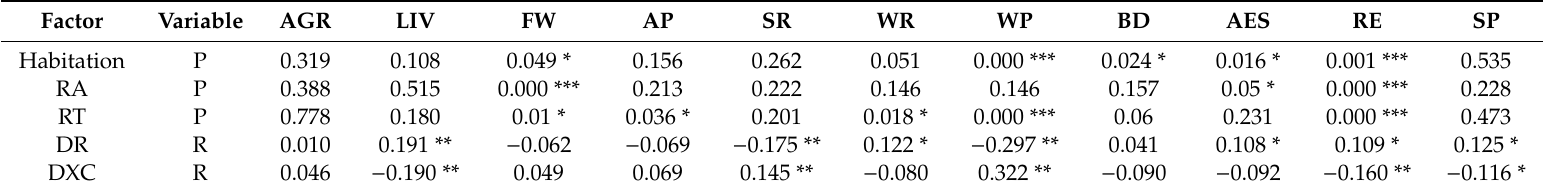
Table 2. Correlation coe ffi cient, p value, and significance of residential